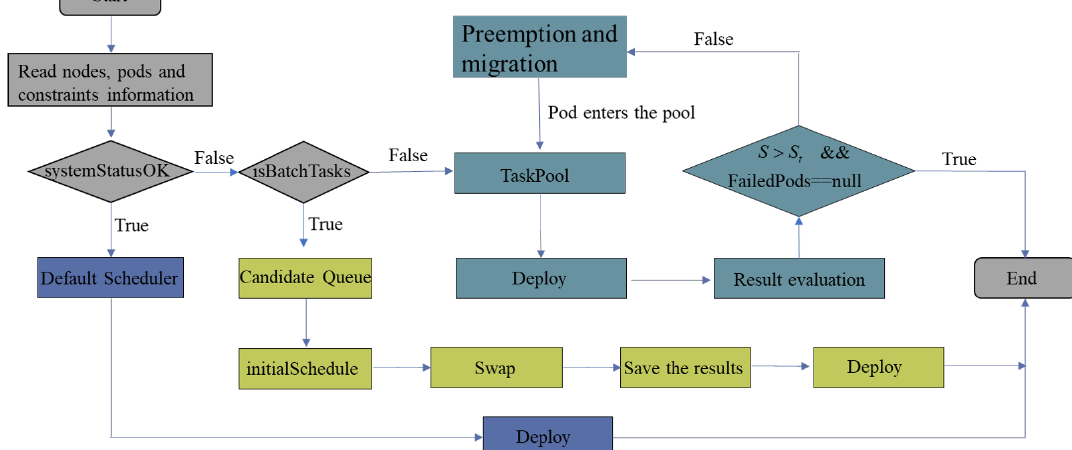
Figure 4. Flow chart of the